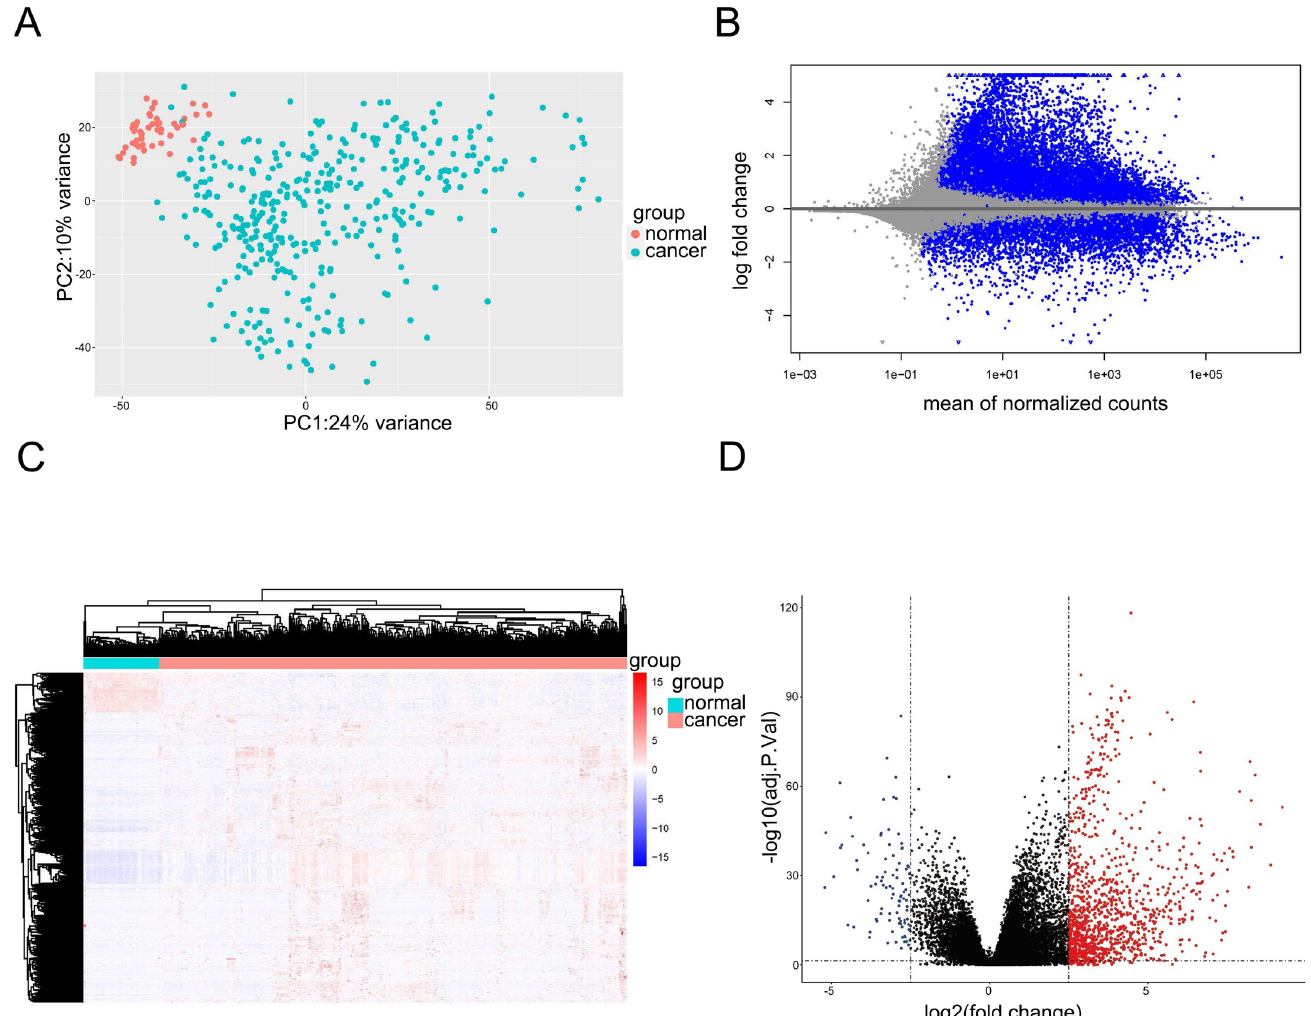
Fig 1. Identification of expression differences between LIHC samples and normal adjacent samples. A. PCA of 371 LIHC samples and 50 normal adjacent samples expression analysis. Red represented normal adjacent samples, and blue represented LIHC samples; B.MA-plot of the differential mRNA expression analysis; C. Heat map of the differential mRNA expression analysis. Blue represented normal adjacent samples, and red represented LIHC samples; D. Volcano plot of the differential mRNA expression analysis. Red represented differential mRNAs that were highly expressed in LIHC samples.